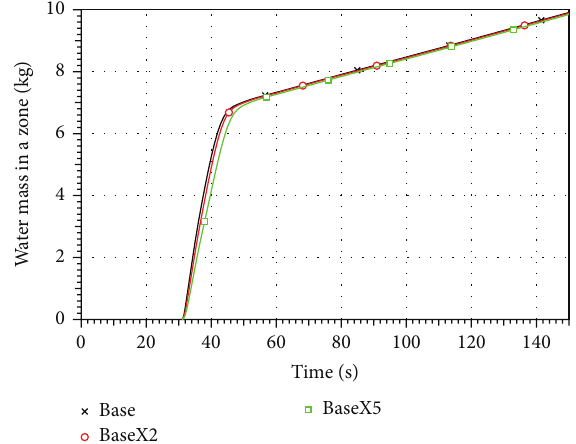
Figure 19: Pressure losses: comparison of total water mass in the piping of venting